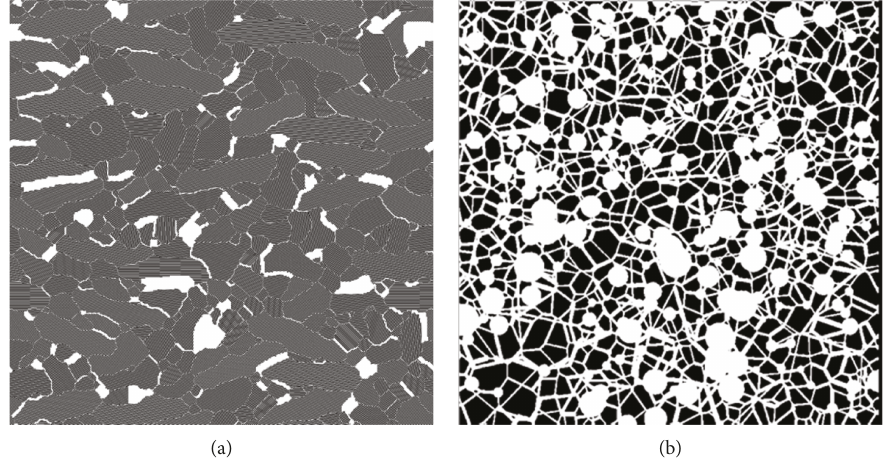
Figure 2: Digitally reconstructed pore maps. (a) Clay-type structure using lattice Monte Carlo methodology. (b) Generic porous medium based on Voronoi tessellation.